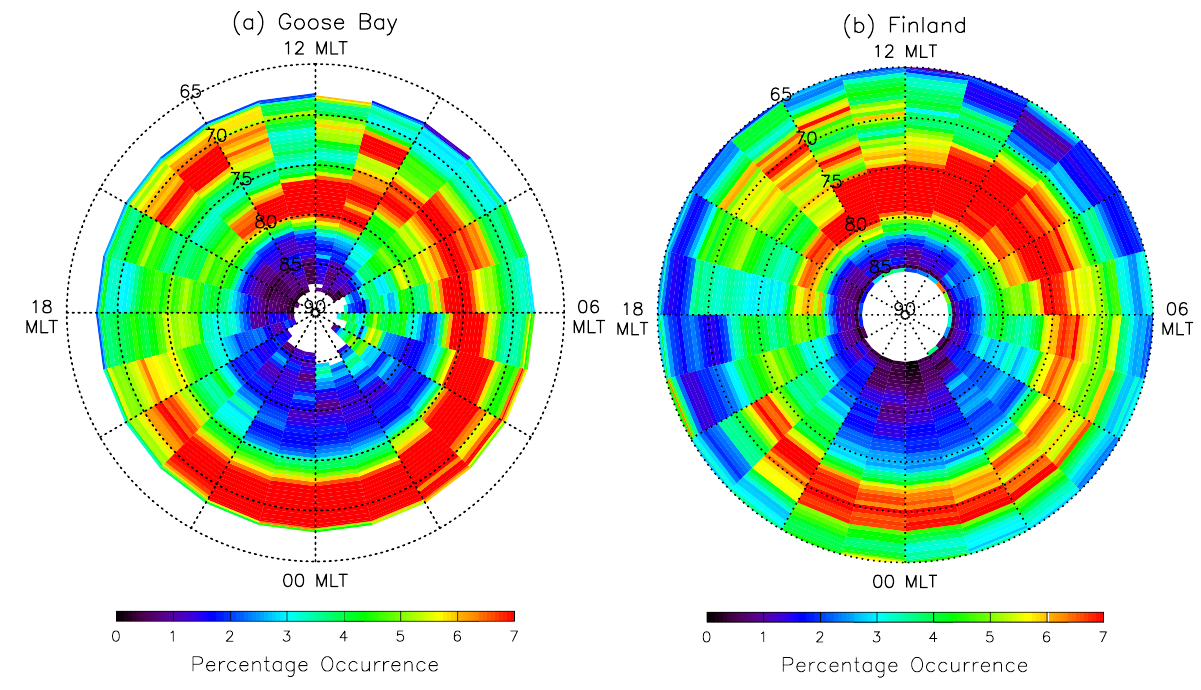
Figure 1a Figure 1b Fig. 1. The probability distributions of the observed SWB locations determined within the 5-year databases for the (a) Goose Bay, and (b) Finland SuperDARN radars, using the C-F threshold technique, smoothed by the application of a 5-range gate moving average. The distributions are presented in AACGM latitude and MLT